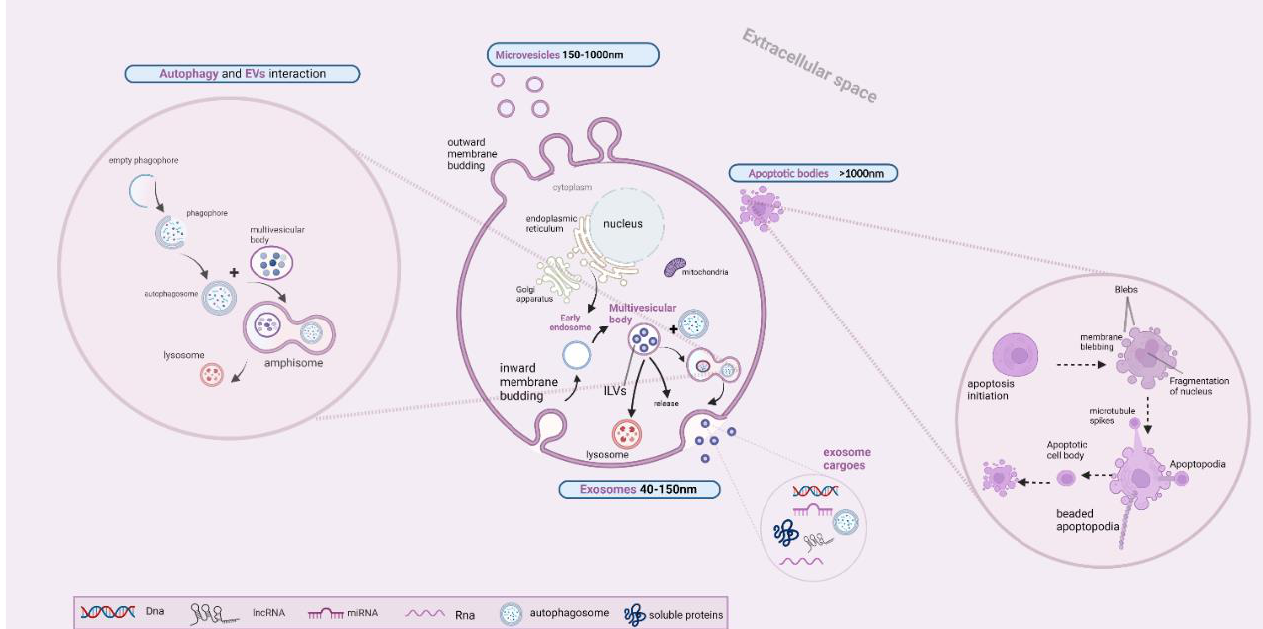
Figure 3. A schematic presentation of EVs biogenetic mechanism. Exosome formation begins with the inward budding of the membrane, with the formation of microvesicles and the internalization of transmembrane proteins. Microvesicles are separated from cell membrane and subsequently form early endosomes with the internalized molecules being either delivered back to the cell membrane or further directed into the intraluminal vesicles (ILVs). The ILVs are split into the lumen of MVB, with MVB being either fused with the cell membrane for the exocytosis of exosomes or being fused with autophagosome and lysosome, forming amphisome, or being led to the lysosome for degradation. Microvesicles biogenesis starts with the outward budding of the plasma membrane, while the production of apoptotic bodies is through cell apoptosis with the formation of the apoptotic cell body and apoptotic bodies. This figure was created with “BioRender.com” accessed on 27 August 2022. (Agreement number QX24C1405A.)